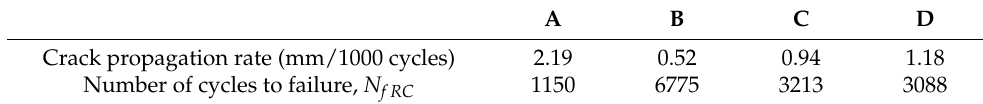
Figure 13. Crack evolution in a specimen with geocomposite A: beginning of the second ( a ) and third ( b ) stages. Table 2. Synthetic parameters obtained from reflective cracking tests for different interface